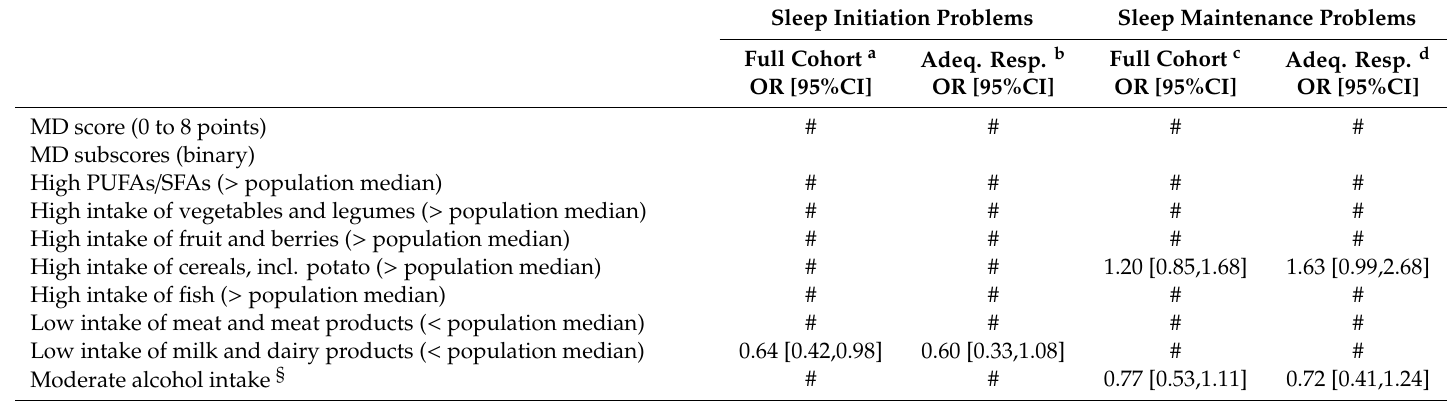
Table 2. Association between adherence to the Mediterranean diet and self-reported sleep problems in older Swedish men. Sleep Initiation